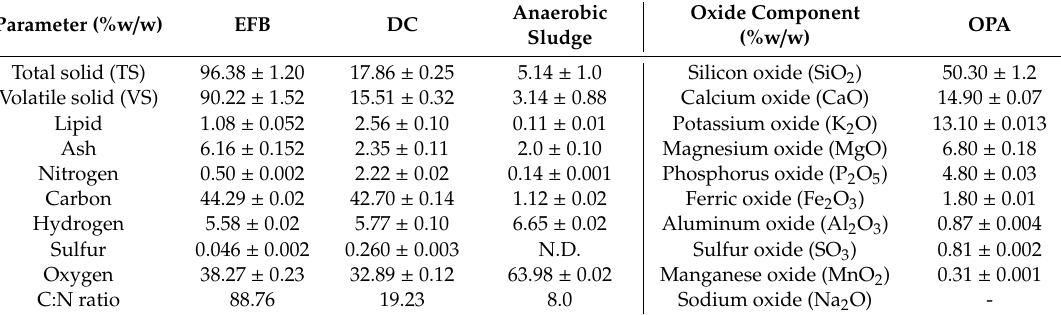
Table 1. Characteristics of empty fruit bunches (EFB), decanter cake (DC), anaerobic sludge and oil palm ash